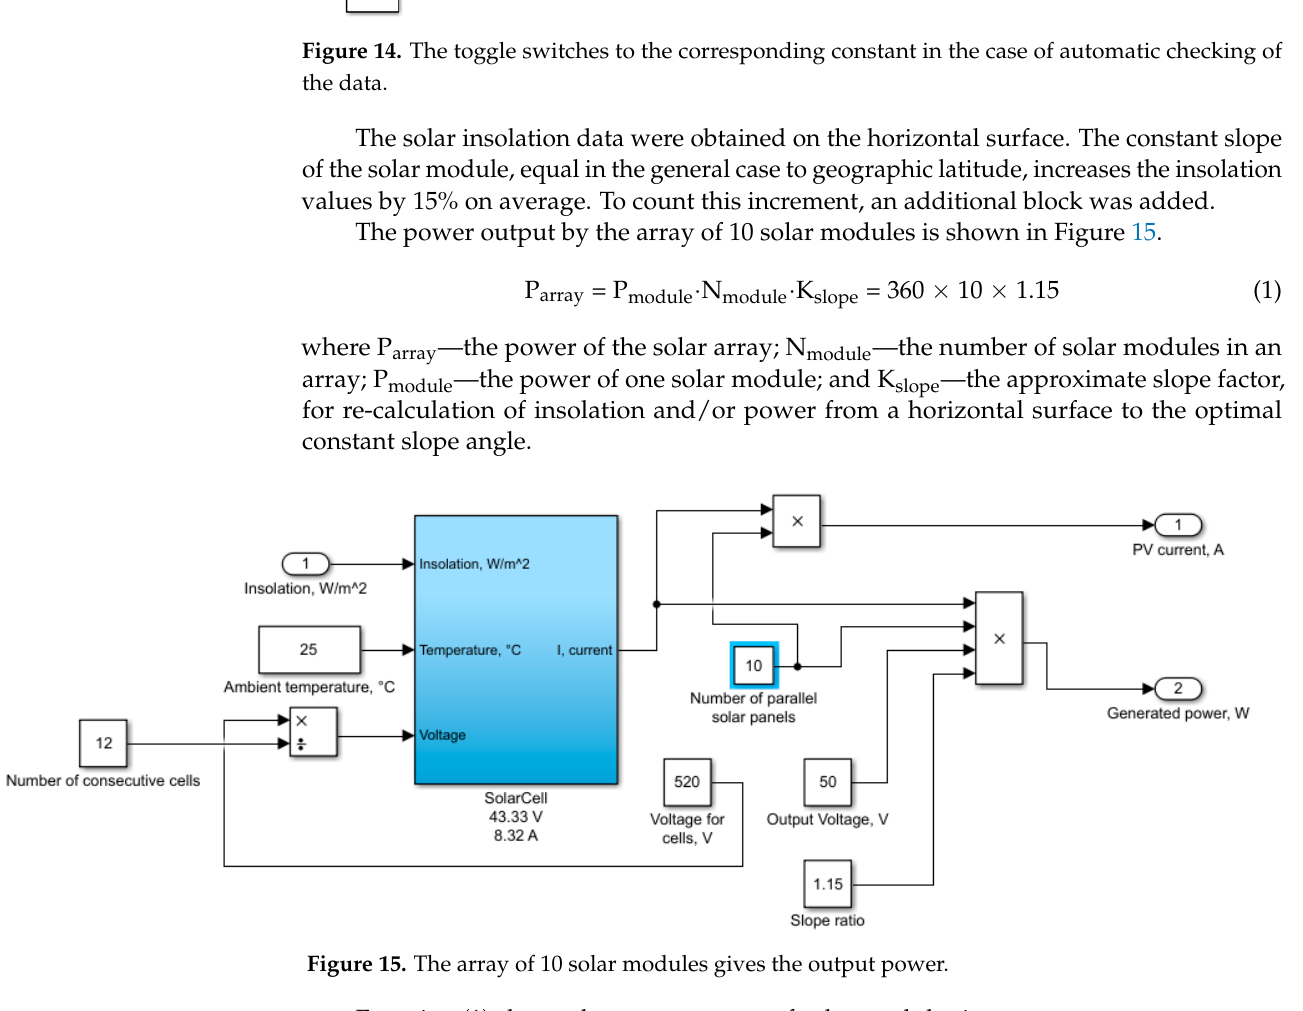
Figure 15. The array of 10 solar modules gives the output